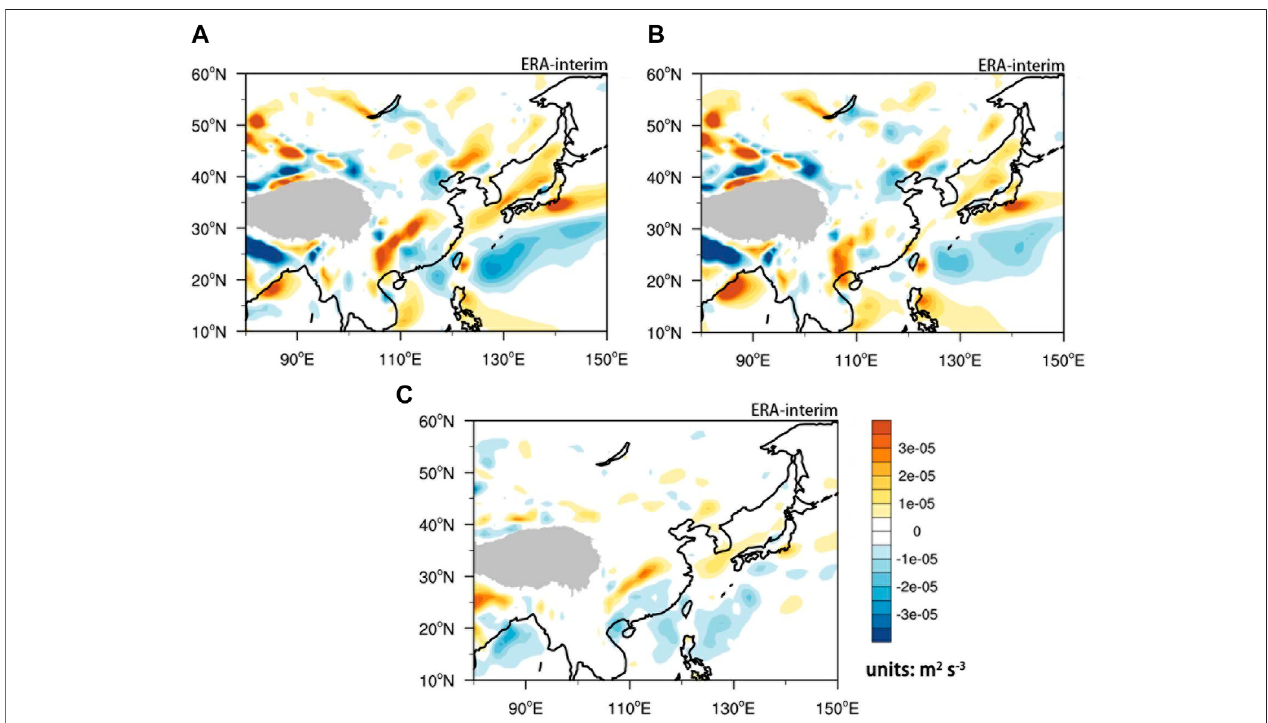
FIGURE 7 | The distributions of barotropic energy conversion at 850 hPa in (A) PHRE years (B) non-PHRE years, and (C) the differences between the two during the Meiyu period (units: m 2 s − 3 ).